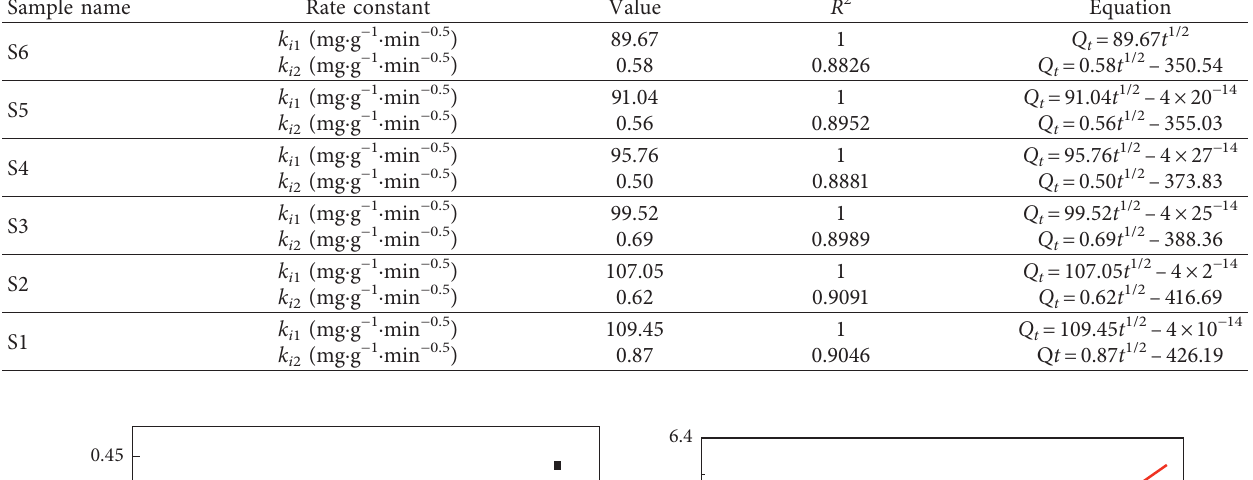
Table 3: Intraparticle diffusion model for adsorption of Cr(VI) onto various Fe